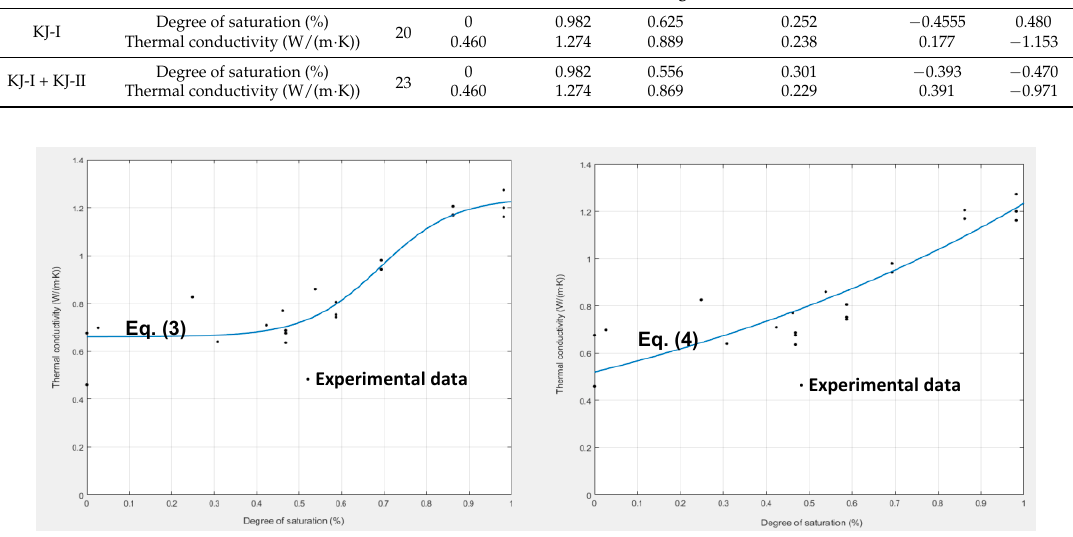
Figure 4. Fitting curves for Equations (3) and (4). Table 5. Summary of predictive models.